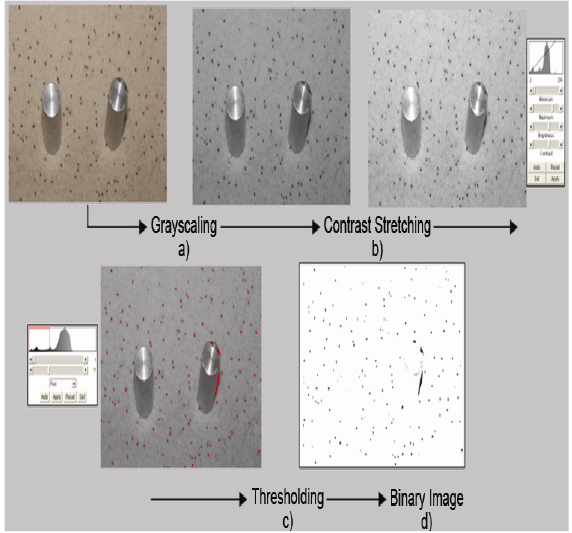
Fig. 5. Digital image processing